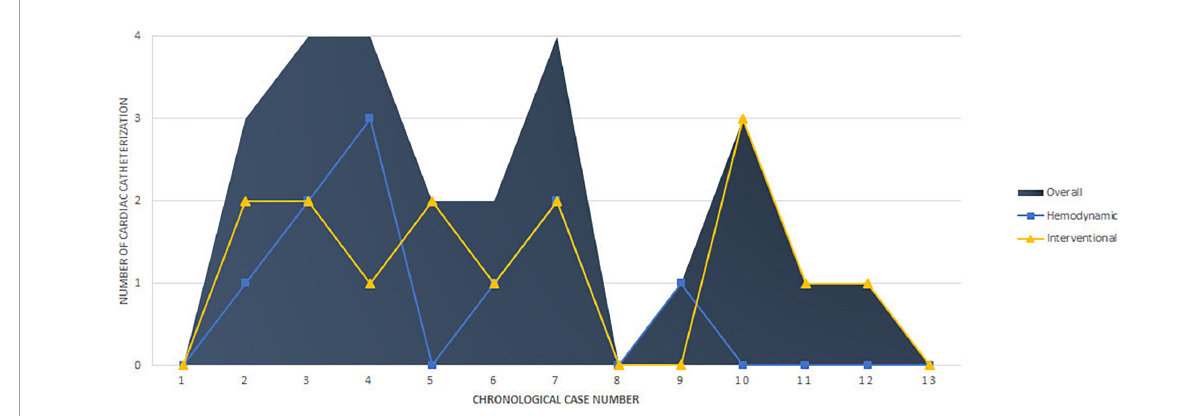
FIGURE4 Number and type of re-catheterization according to chronological case number.